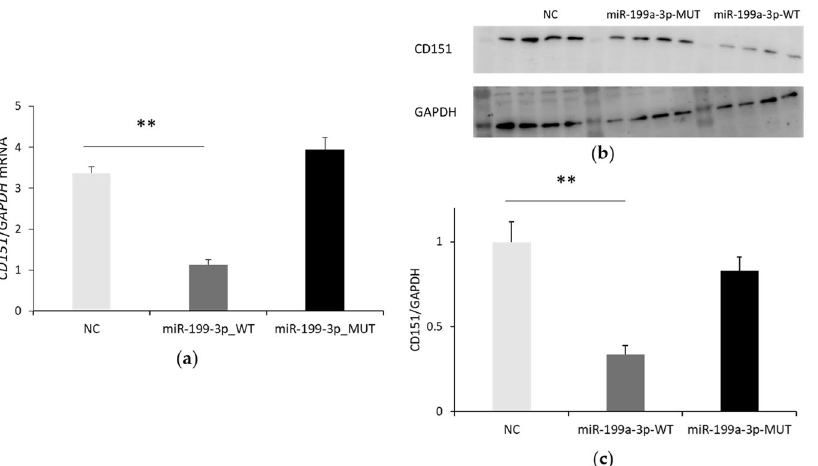
Figure 3. miR-199a-3p could inhibit the expression of CD151. Endogenous CD151 mRNA ( a ) and protein ( b ) expression under the condition of miR-199a-3p overexpression (NC, negative control; MUT, seed region mutated type; WT, wild type) was detected by qRT-PCR and Western blot, respectively; ( c ) Relative expression of CD151 normalized to GAPDH. Every four bands were a replicate, and this experiment was repeated for three times. Student’s t -test was used to compare the differences between miR-199-3p-MUT/WT and NC, and one star ( * ) represented p < 0.05.